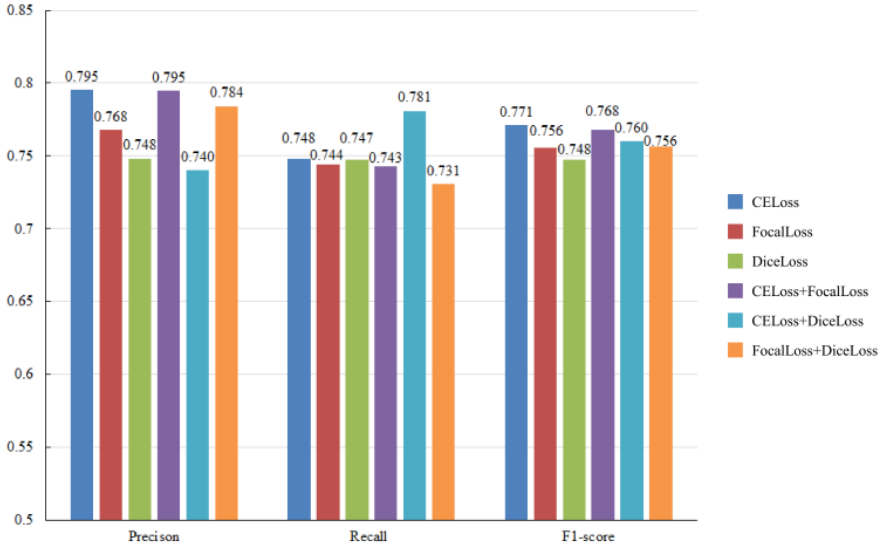
Figure 10. Accuracy metric of each loss function on the test dataset.